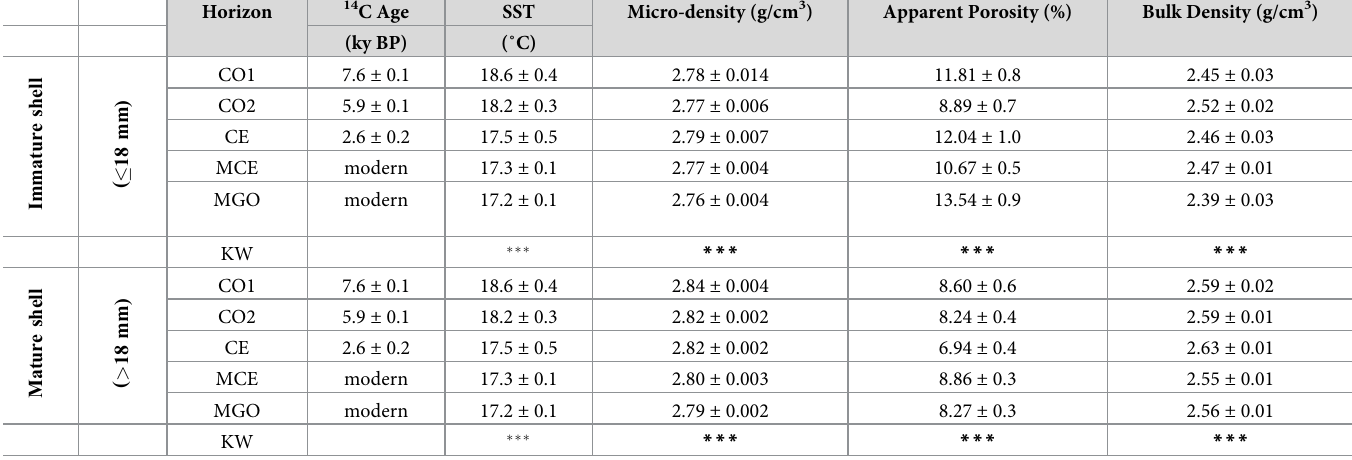
Values for each horizon in chronological order. For each parameter mean value and standard error are reported. Holocene SST are extrapolated from Jalali et al. [36]. K-W = Kruskal-Wallis equality-of-populations rank test; ��� p <